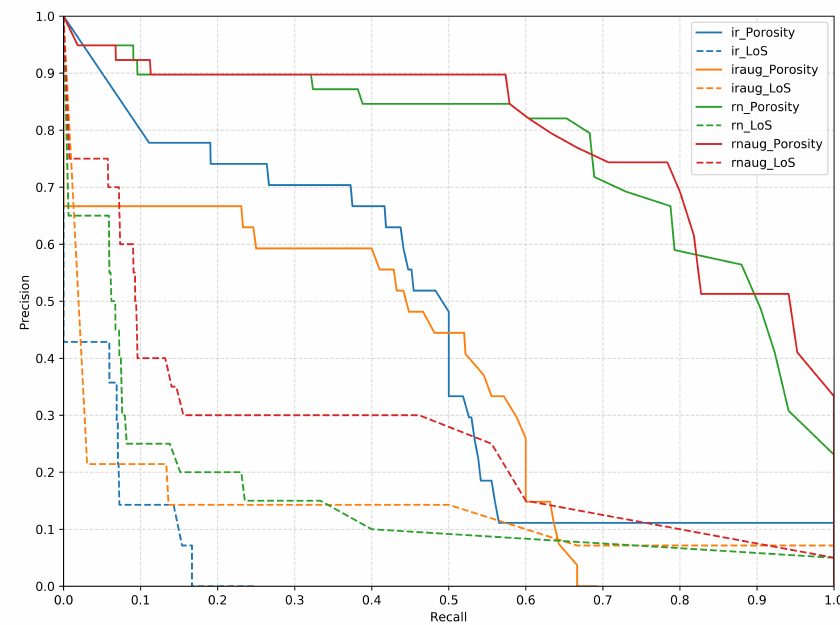
Figure 7. Precision-recall curve. Calculate the average precision of porosity and loss according to PASCAL VOC [16] criteria. The solid line represents porosity, and the dotted line represents LoS for each